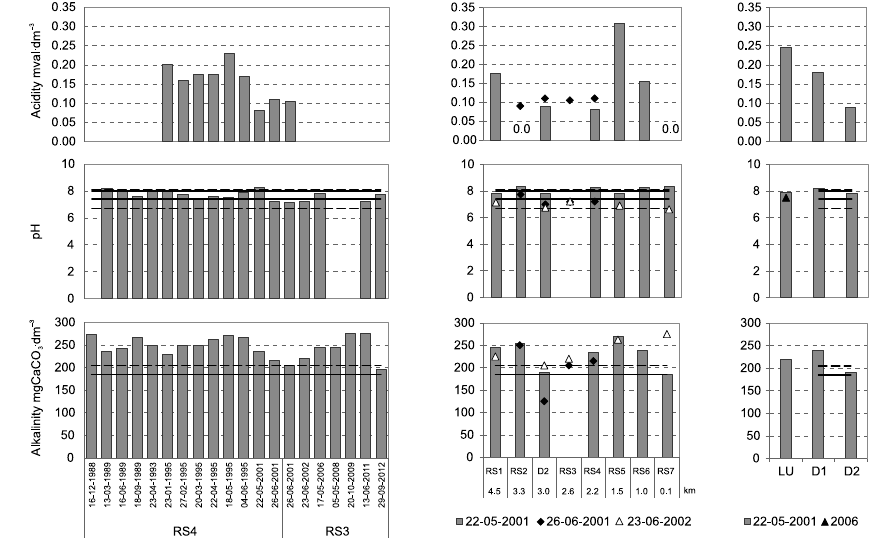
Fig. 11. Indicators of acidification: acidity, pH reaction and alkalinity.